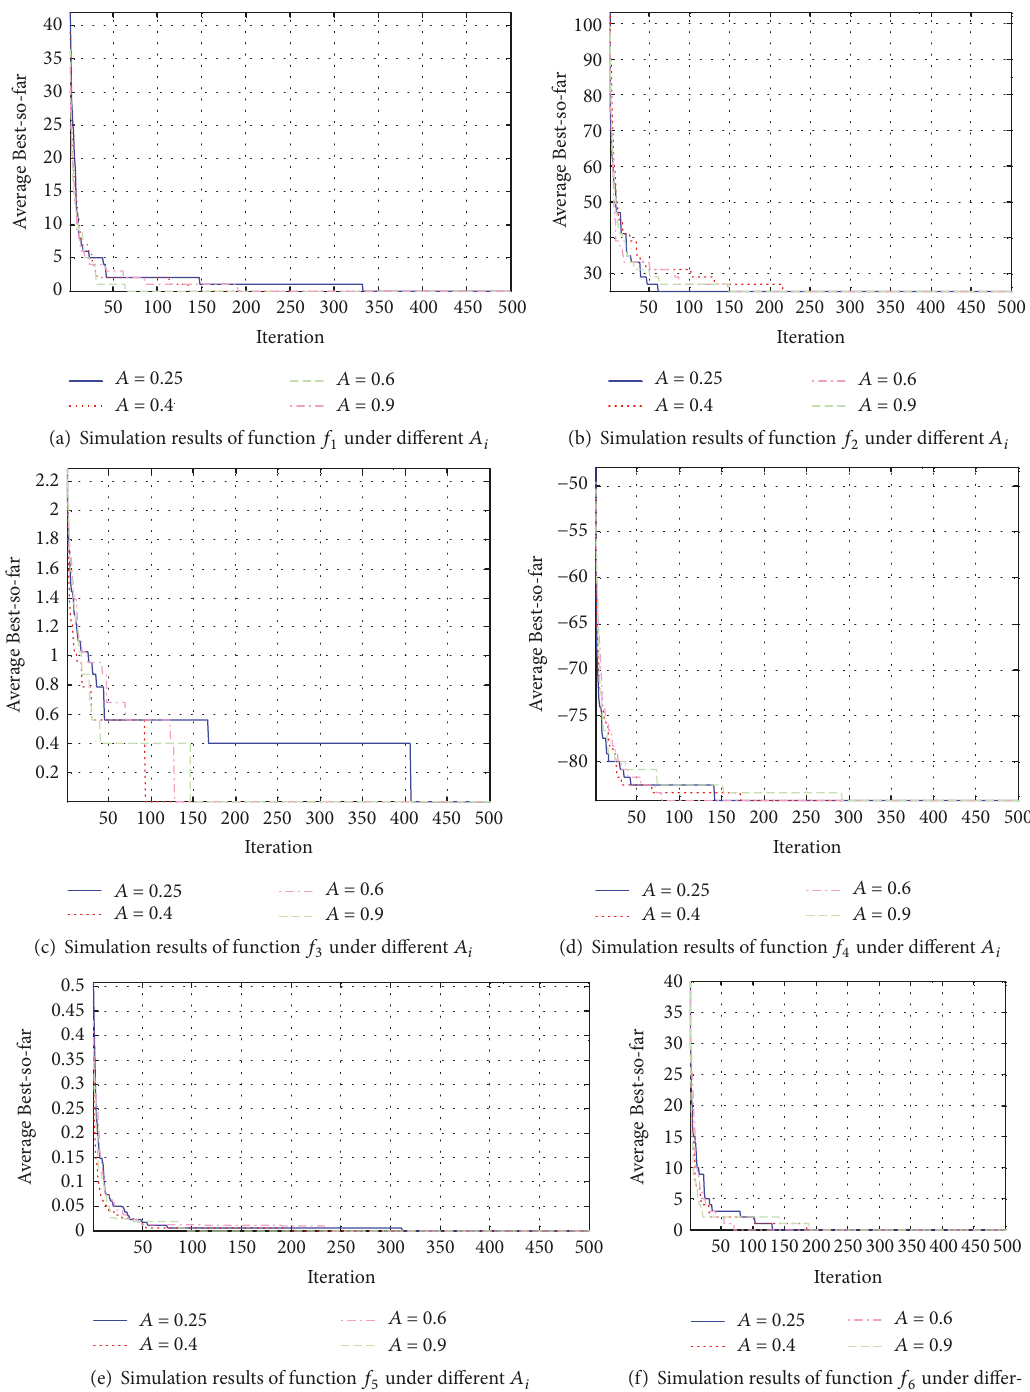
(f) Simulation results of function 𝑓 6 under differ- ent 𝐴 𝑖